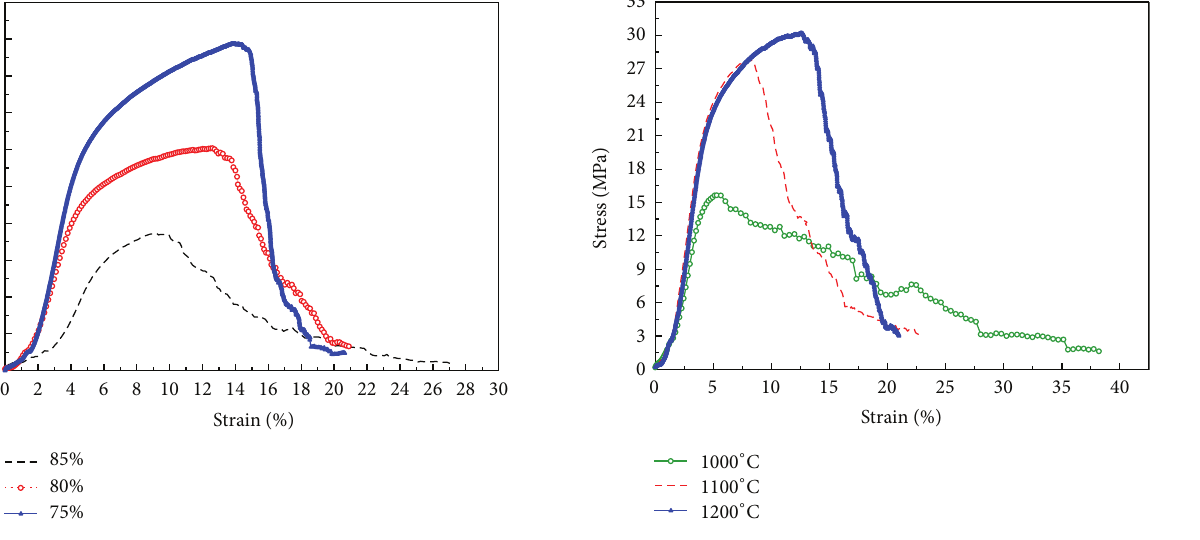
Figure 5: Tensile stress-strain curves of the SSSFF with different porosities (sintered at 1200 ∘ C for 60min).